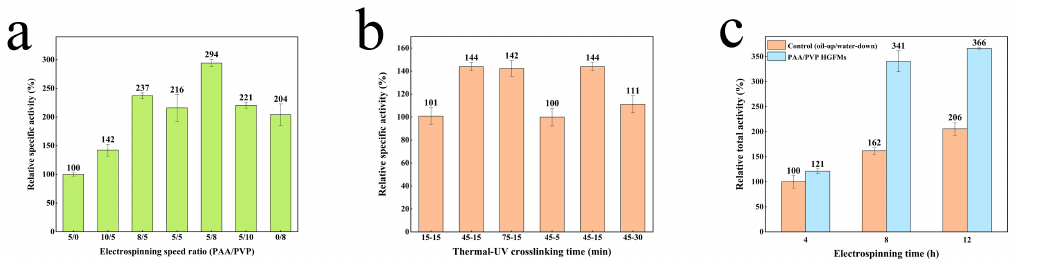
Figure 5. Influence of the component ratio ( a ), crosslinking time ( b ) and electrospinning time ( c ) on the catalytic efficiency of lipase-PAA/PVP HGFM systems. The results shown in ( a , c ) were obtained using a thermal crosslinking time of 45 min and a UV crosslinking time of 15 min. The results shown in ( a , b ) were obtained using an electrospinning time of 8 h. The interfacial area of the macroscopic “oil-up/water-down” system was set equal to the cross-sectional area of the